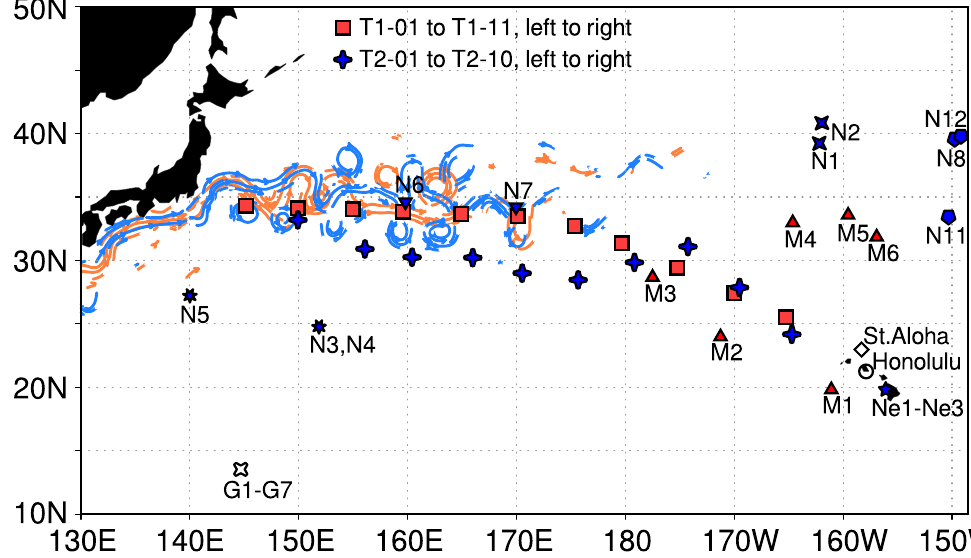
Fig. 1. Map of the western North Pacific between Japan and Hawaii illustrating sampling locations. The red and blue filled symbols represent sampling in 2011 and 2012, respectively; empty symbols are used for stations where sampling was performed in both years (for details see Tables 1 and 2). The contours of an average ocean surface velocity > 0.4ms − 1 were calculated by the SCUD model for June 2011 (red) and June 2012 (blue) to visualize the major Kuroshio and Kuroshio extension currents (Maximenko and Hafner,